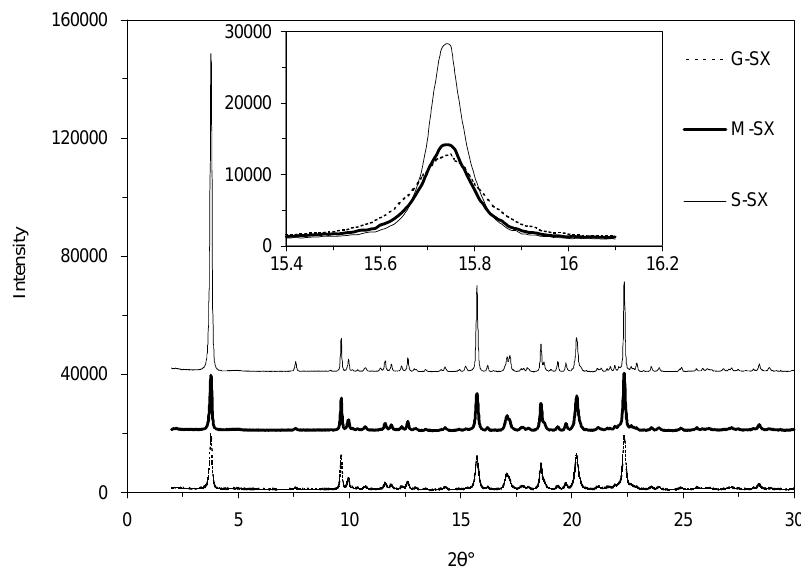
X-ray diffraction patterns of salmeterol xinafoate samples: granulated (G-SX), micronised (M-SX) and SEDS-produced (S-SX) obtained at the wavelength 1.4 Å. The inserted diagram allows a comparison between characteristic (1 — 13) diffraction peaks for these samples.